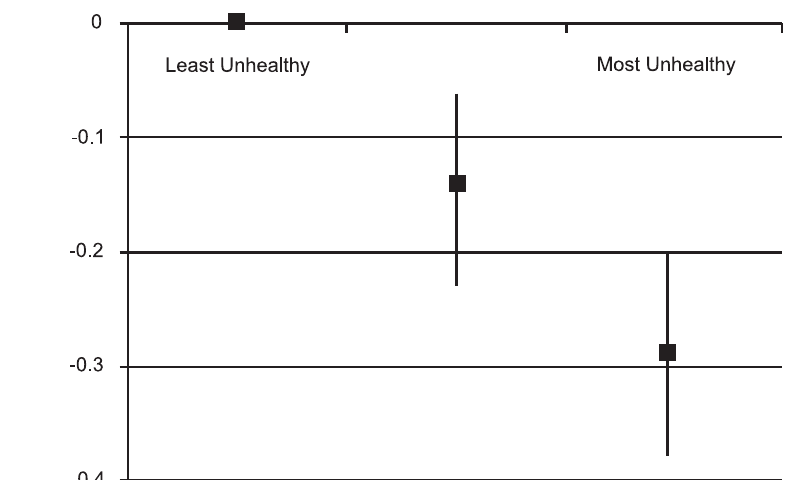
Figure 2. Cross-sectional associations between Unhealthy diet scores and PedsQL scores (z-score standardized) after adjustments for gender, age, dieting behaviours, BMI, SES and PA.